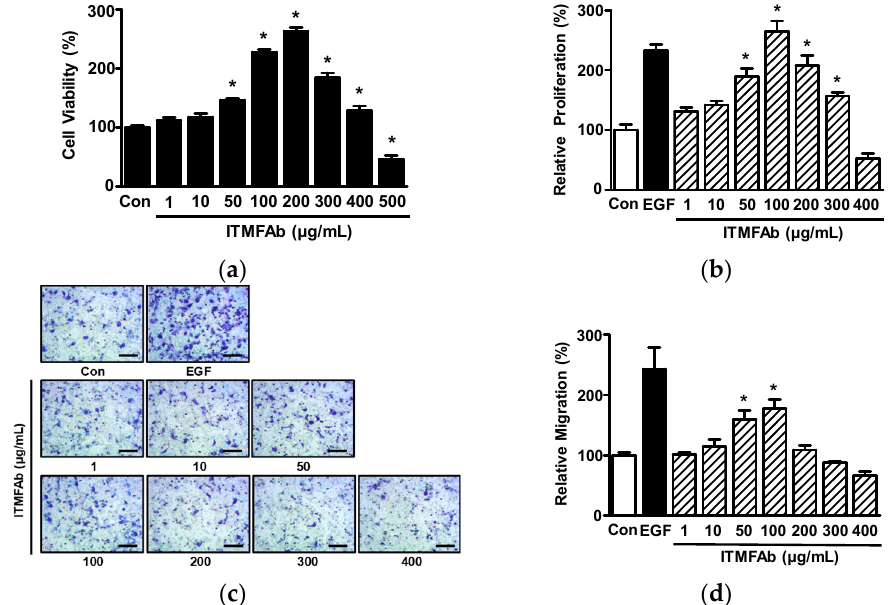
Figure 2. Effects of Impatiens textori Miq. flower absolute on the viability of HaCaT cells, proliferation, and migration. ( a ) Cell viability. HaCaT cells were incubated with Impatiens textori Miq. flower absolute (ITMFAb; 1–500 µ g/mL) for 48 h and cell viabilities were evaluated using the WST assay ( n = 5) ( b ) Cell proliferation. HaCaT cells were treated with ITMFAb (1–400 µ g/mL) for 48 h, and a growth factor (EGF: 50 ng/mL): positive control. Cell proliferation levels are presented as percentages of those of non-treated controls (Con). Data are expressed as means ± standard errors of